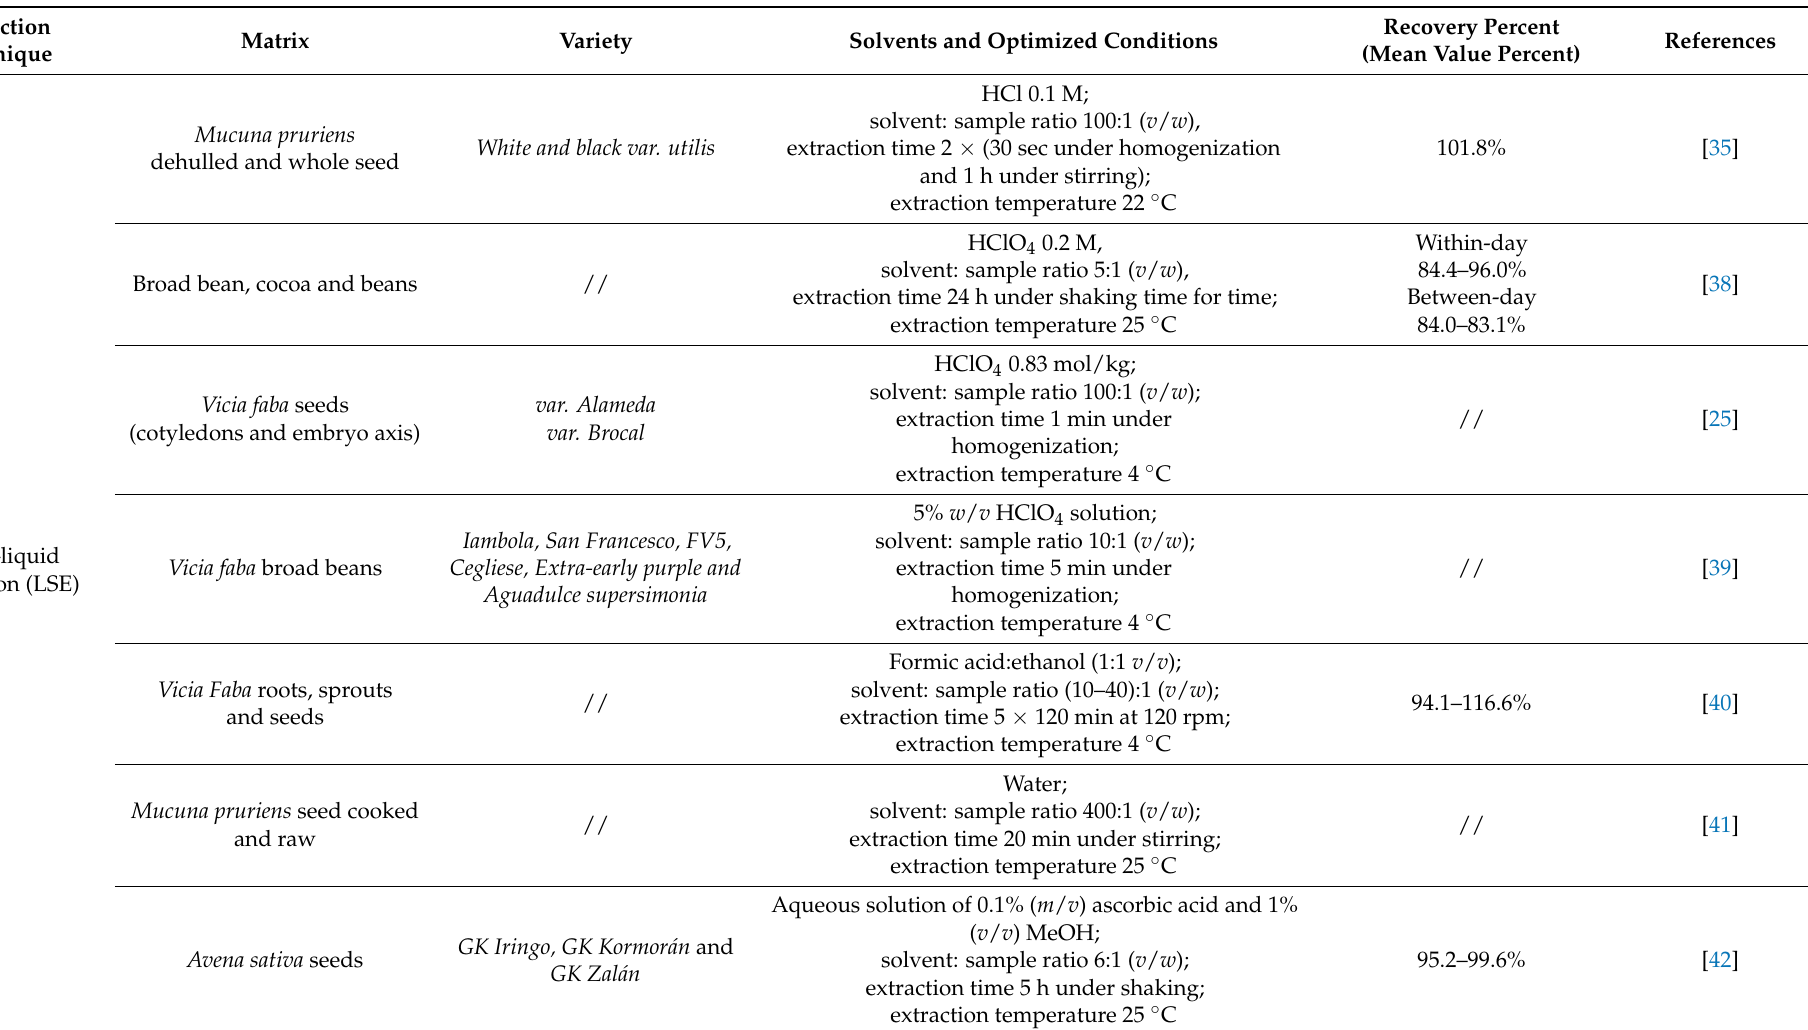
Table 1. Overview of the methods used for LD extraction occurring in plant